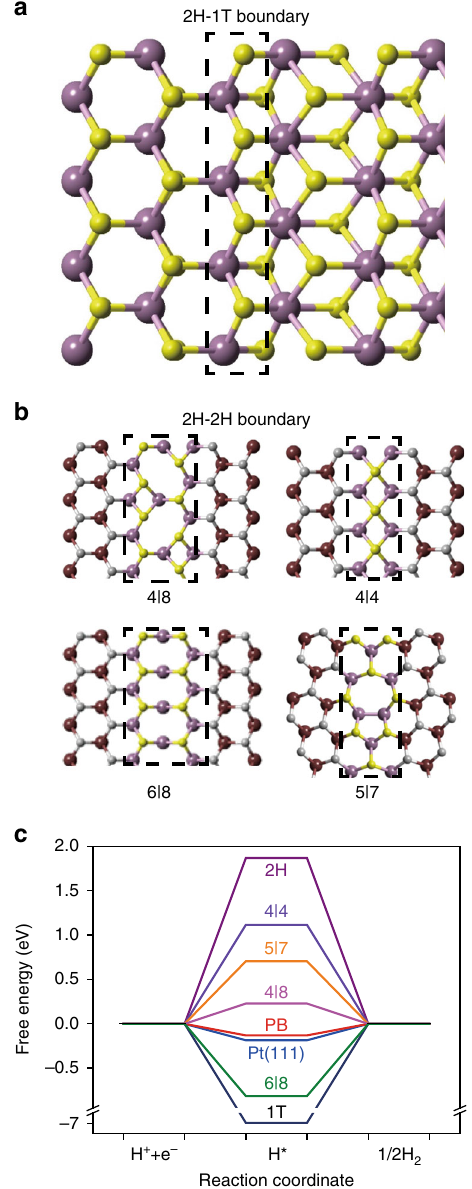
Fig. 3 Theoretical simulations. a , b The top views of the atomic model of the zigzag type 2H – 1T-phase boundaries and four kinds of 2H – 2H boundaries (4|8, 6|8, 4|4, 5|7). c A comparison of the Gibbs free energies of the adsorbed H on 2H-phase of MoS 2 , 1T-phase of MoS 2 , Pt(111)